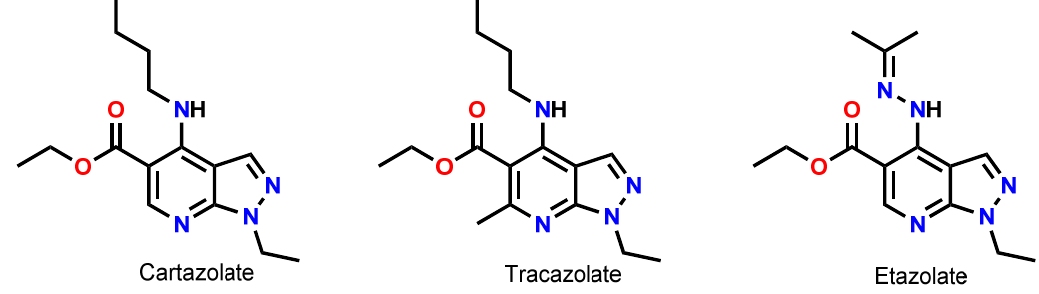
Figure 1. Structure of cartazolate, etazolate, and tracazolate.